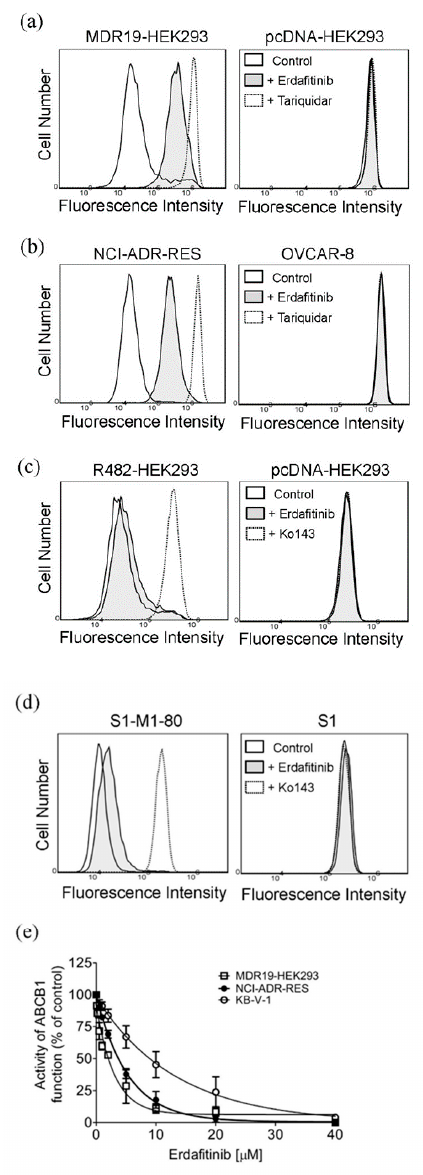
Figure 2. Erdafitinib increases the intracellular accumulation of ABCB1 fluorescent substrate drug in ABCB1-overexpressing cells. The intracellular accumulation of calcein, a fluorescent product of a known ABCB1 substrate calcein-AM, was determined in the ( a ) ABCB1-transfected MDR19-HEK293 cells (left panel) and the corresponding drug-sensitive parental HEK293 cells (right panel), and the ( b ) ABCB1-overexpressing NCI-ADR-RES cancer cells (left panel) and the corresponding drug-sensitive parental OVCAR-8 cancer cells (right panel), whereas the intracellular accumulation of pheophorbide A (PhA), a known ABCG2 fluorescent substrate drug, was determined in ( c ) ABCG2-transfected R482-HEK293 cells (left panel) and the corresponding drug-sensitive parental HEK293 cells (right panel), and the ( d ) ABCG2-overexpressing S1-M1-80 cancer cells (left panel) and the corresponding drug-sensitive parental S1 cancer cells (right panel). Cells were treated with DMSO (solid line), 1 µ M of erdafitinib (filled solid line) or a reference inhibitor (dotted line) for ABCB1 (3 µ M tariquidar, a , b ) or for ABCG2 (1 µ M Ko143, c , d ) as a positive control. The respective fluorescent signals were analyzed by flow cytometry as described previously [39]. Representative histograms of at least three independent experiments are shown. ( e ) Concentration-dependent inhibition of ABCB1-mediated calcein e ffl ux in MDR19-HEK293 cells (open squares), NCI-ADR-RES (filled circles) and KB-V-1 cancer cells (open circles). Points, mean values from at least three independent experiments; bars;